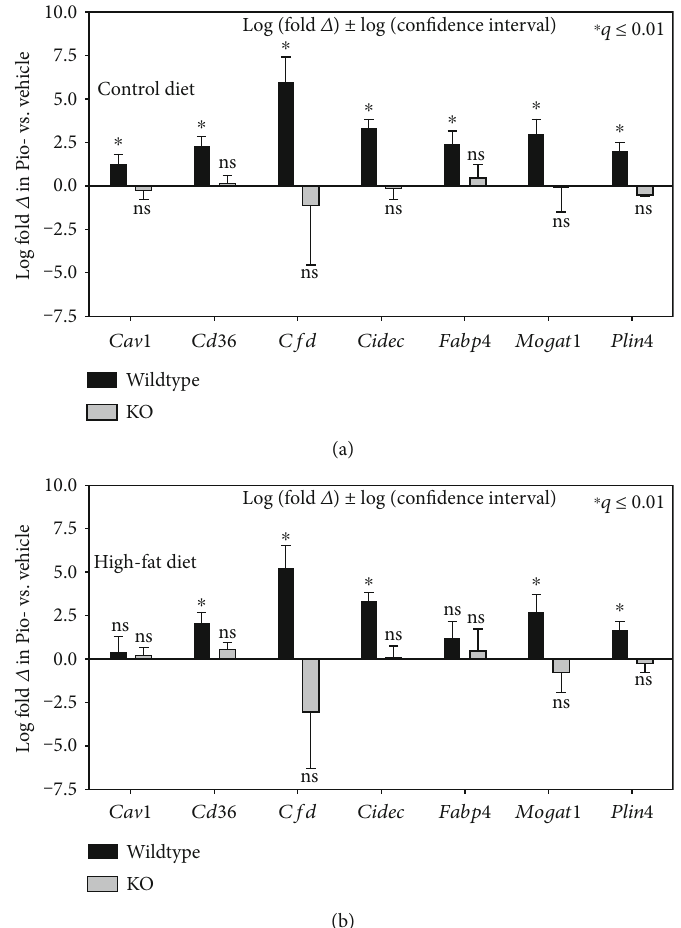
Figure 3: E ff ects of Pio on hepatic expression of exemplar genes. Summary of RNA-Seq data of exemplar genes whose expression is known to be regulated by PPAR γ . ∗ q ≤ 0 : 01 ; ns: no signi fi cant di ff